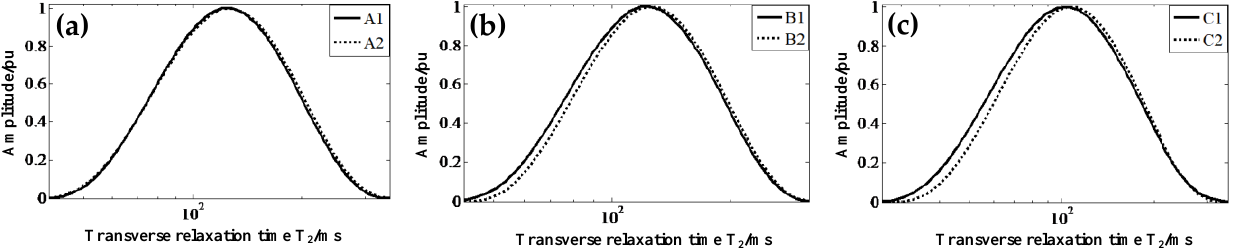
3.2. Measurement of Difference between Upper and Lower Surfaces of the Same Shed